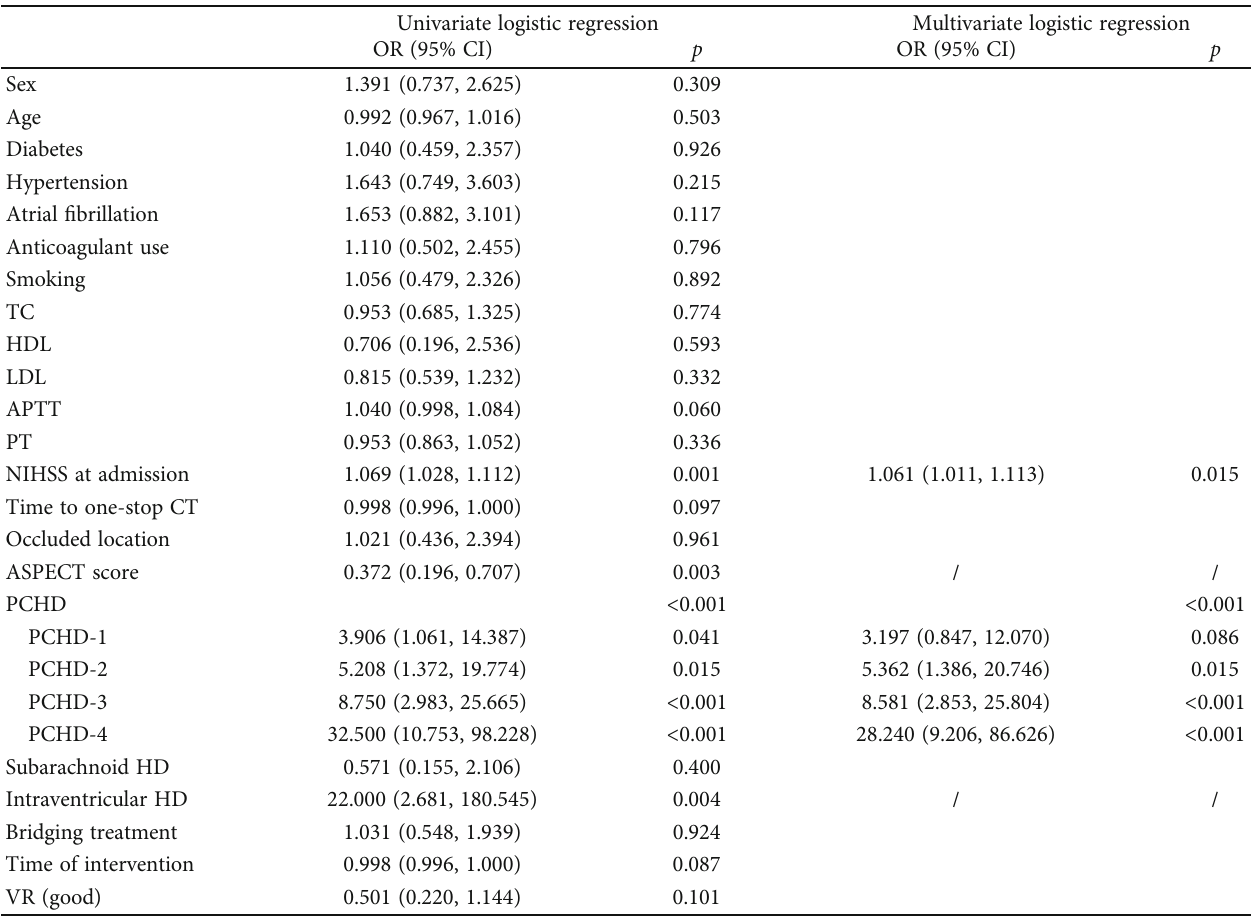
Table 3: Stepwise logistic regression analysis predicting